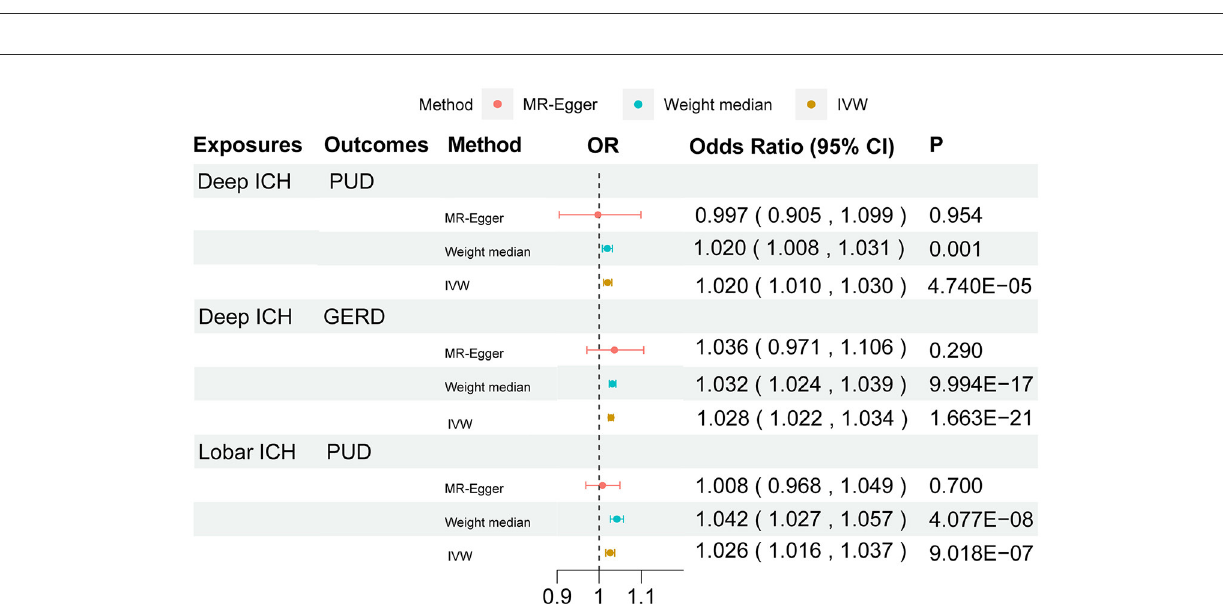
FIGURE3 Forest plot for the causal effect of stroke on the risk of gastrointestinal disorders. OR, odds ratio; CI, confidence interval.